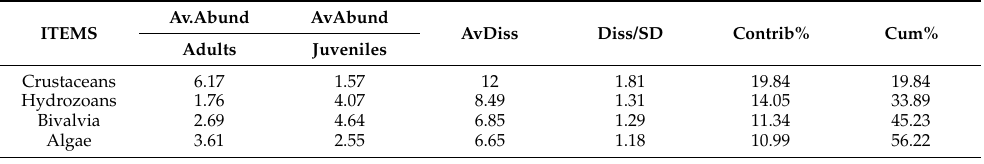
Table 4. Contribution of principal food items (%) to dissimilarity in stomach contents between adults and juveniles of Lithodes santolla from Cabo de Hornos. Av.Abund = average abundance of prey item, Av.Diss = average dissimilarity, Diss/SD = average contribution divided by the standard deviation, Contrib% = Contribution to the dissimilarities, Cum% = Cumulative contribution to the dissimilarities. All items representing >10%.